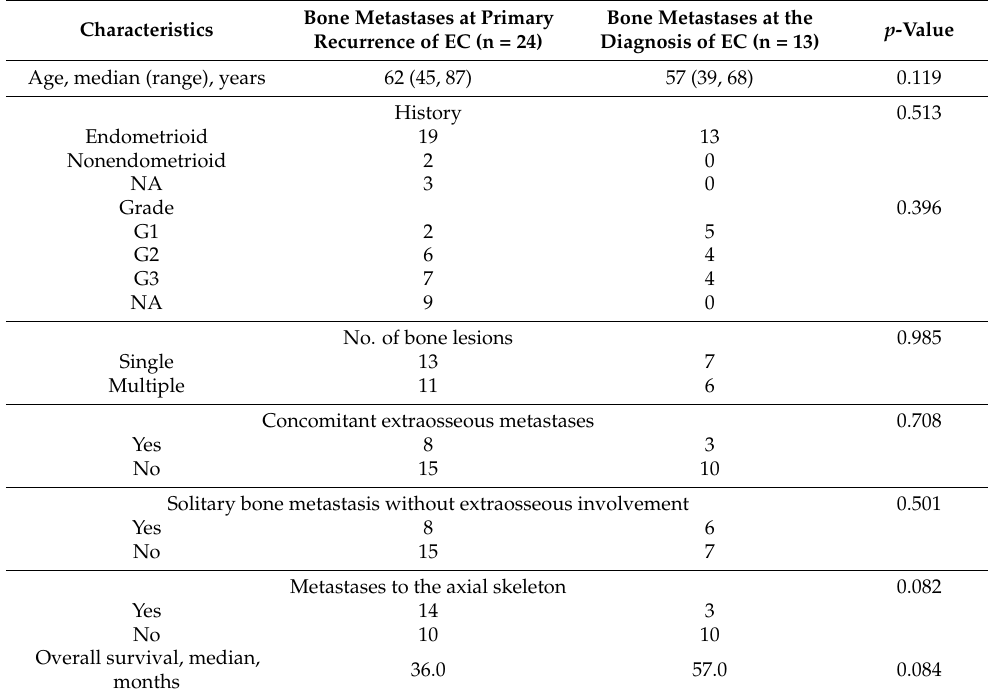
Table 3. Overall characteristics of 37 patients with primary bone metastases of EC treated by surgery. Bone Metastases at Primary Bone Metastases at the p Characteristics Recurrence of EC (n = 24) Diagnosis of EC (n = 13)